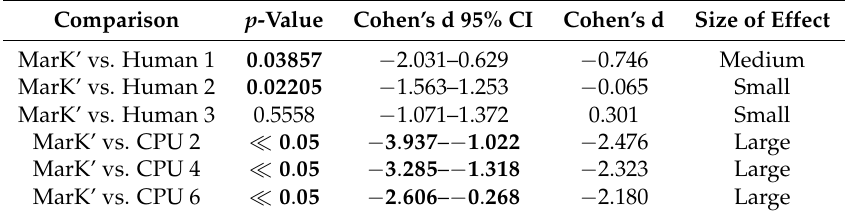
Table 2. Third-person Turing test